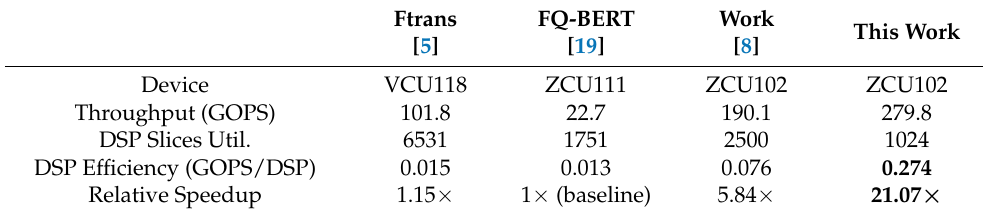
Table 6. Comparison of Design against related